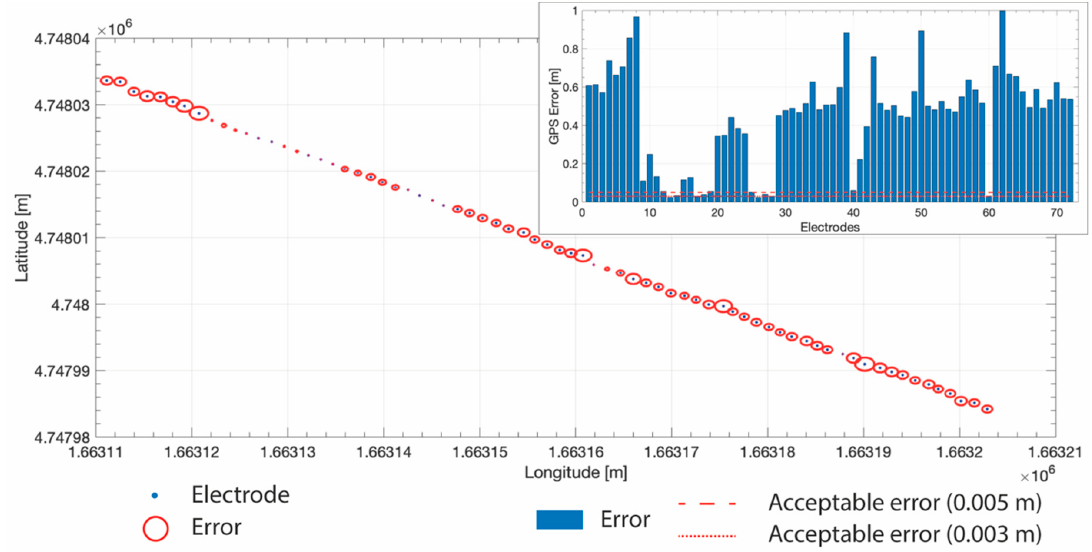
Figure 2. The GPS-errors, that affect the coordinates measures of each electrode, shown as blue bar (in the insert in the upper right corner) and as red circle around the “real” electrode position in the main panel (x and y axes are the longitude and latitude coordinates, respectively, in the Gauss Boaga-Roma40 projected system). In the insert (upper right corner) the red dashed line at 0.05 m is the imposed GPS threshold employed in the field acquisition, i.e., the error value imposed as acceptable (see text), while the red pointed line at 0.03 m is another possible threshold commonly used in field acquisition.